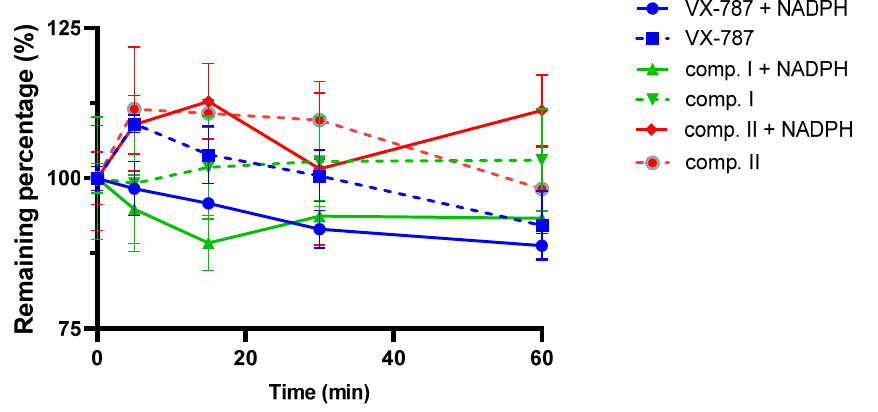
Figure 4. Residual percentage of VX-787 and comp. I / II in rat liver microsomes. Error bars are represented as mean ± SD, n = 3.